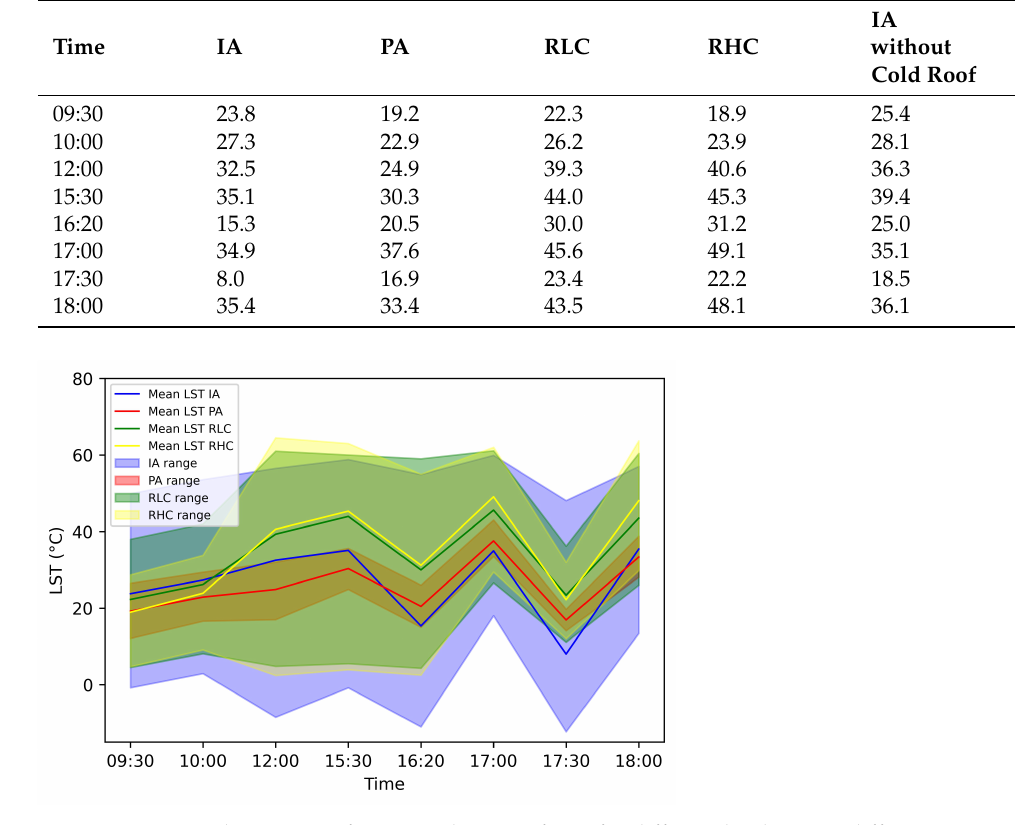
Figure 4. Temporal variation of mean and range of LST for different land uses at different times of the day.